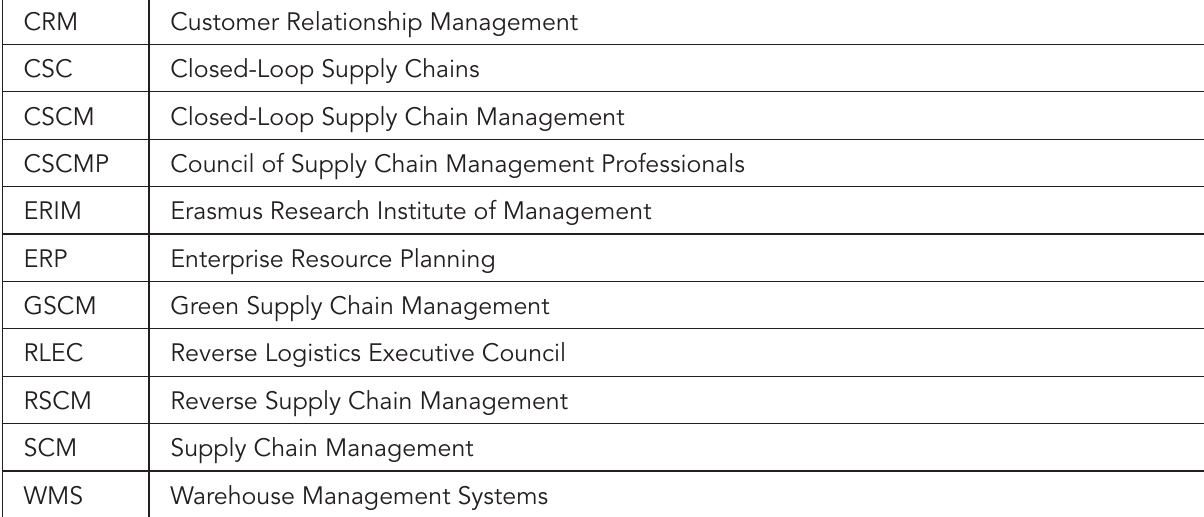
CRM Customer Relationship